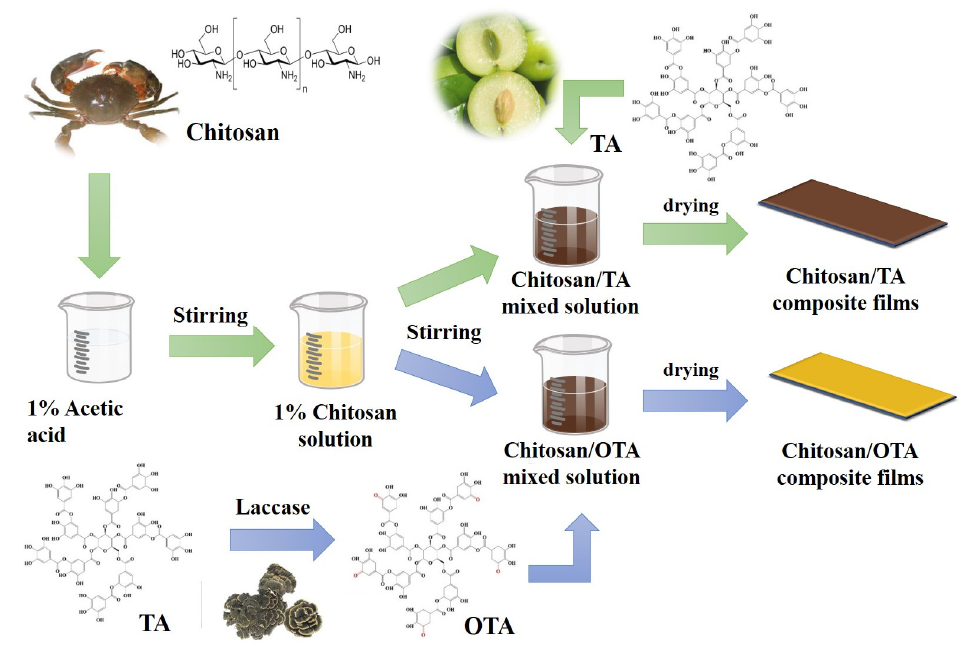
Scheme 2. A schematic representation of the development of the chitosan (CS), chitosan/tannic acid (CTA), and chitosan/oxidized tannic acid (COTA) films. Table 6. The composition ratios of the composite